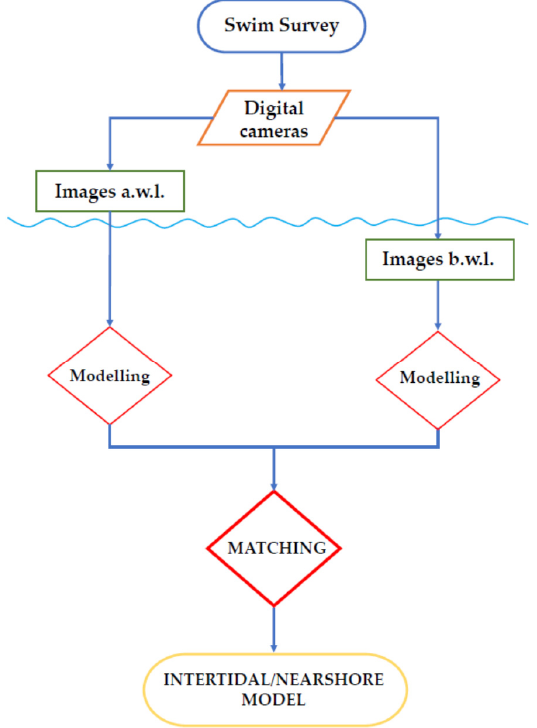
Figure 2. Diagram of the acquisition and modeling procedures.